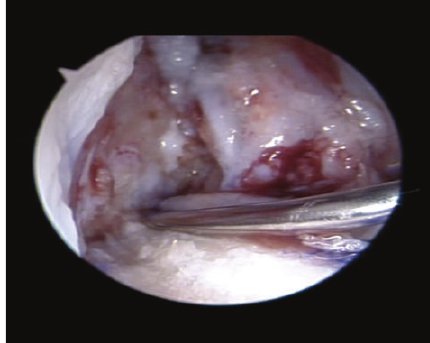
Figure 2: Once the graft is fixed within the tunnel, the remaining 3 mL of PRP is injected into the femoral tunnel using an